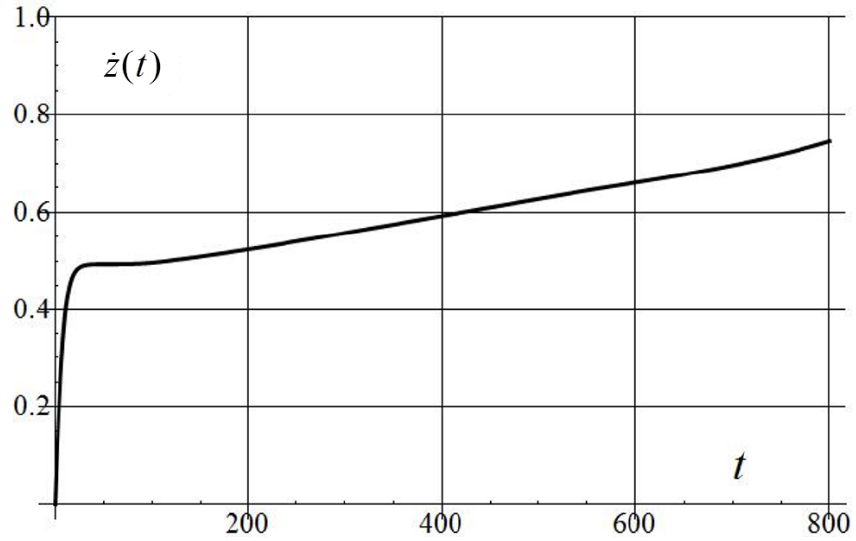
Figure 28. Speed of submersion versus time: Northern seas, sphere, l ∗ = l s = 1/3, η =